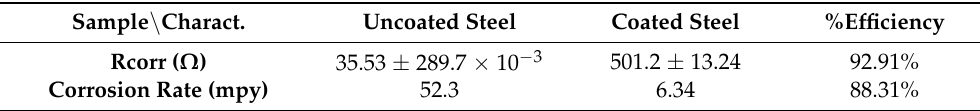
Table 5. Results from the electrochemical tests.